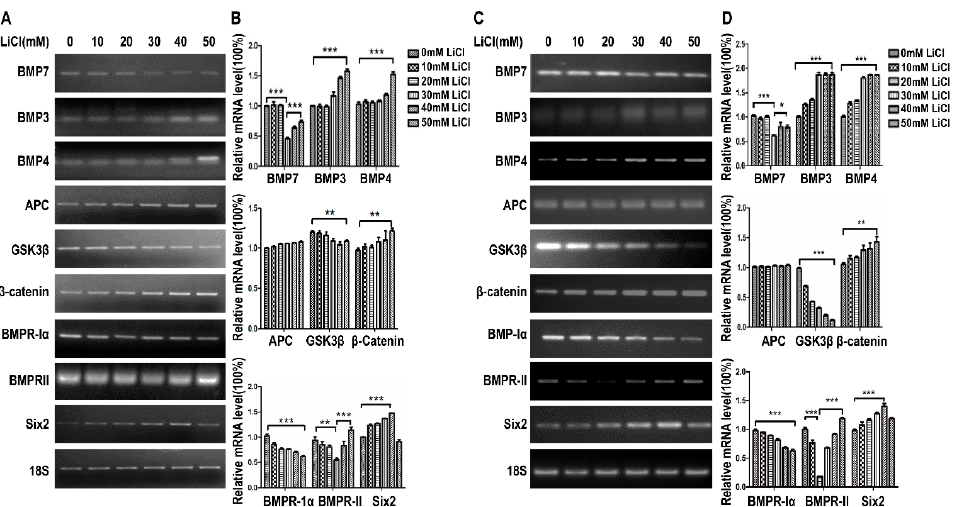
Figure 2. LiCl activates Wnt and BMP signaling pathway. ( A ) mK3 cells were treated with LiCl of increasing dosages (0, 10, 20 M, 30, 40, and 50 mM) for 12 h. The expression Wnt and BMP Signal markers were detected for confirming the function of LiCl by RT-PCR; ( B ) The relative mRNA expressions in mK3 cells was quantified by gray scan, normalized to the internal control 18S. Values were presented as mean ± SEM ( n = 3). p -values were calculated by Student t -test, ** p < 0.01, *** p < 0.001 relative to control; ( C ) mK4 cells were treated same with mK3 cells and the mRNA expression of the same genes was tested by RT-PCR; ( D ) The relative mRNA expressions in mK4 cells were quantified by gray scan, normalized to the internal control 18S. Values were presented as mean ± SEM ( n = 3). p -values were calculated by Student t -test, * p < 0.05, ** p < 0.01, *** p < 0.001 relative to control.